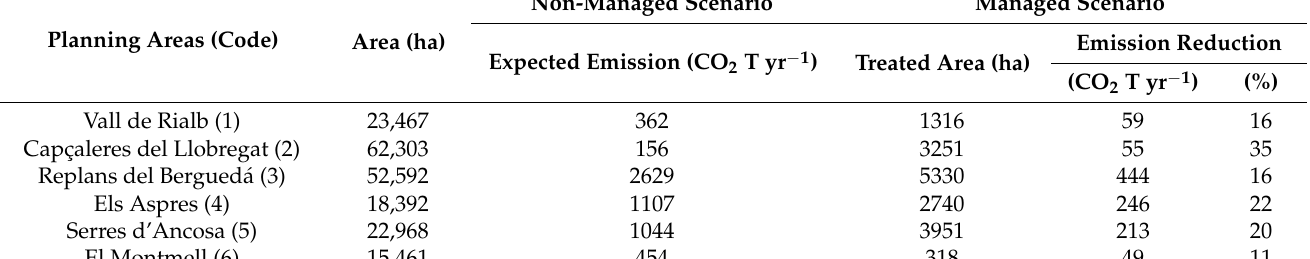
10 of 23 Figure 4. Expected carbon dioxide emissions (CO 2 T ha − 1 y − 1 ) from wildfires occurring under extreme fire-weather conditions within the different planning areas. The numbers refer to the planning area codes (Appendix A; Figure 1). 3.2. Carbon Emission Reduction in Managed Scenarios The landscape-scale emissions in managed scenarios were reduced by between 49 (planning area 6) and 444 CO 2 T per year (planning area 3), which resulted in a reduction